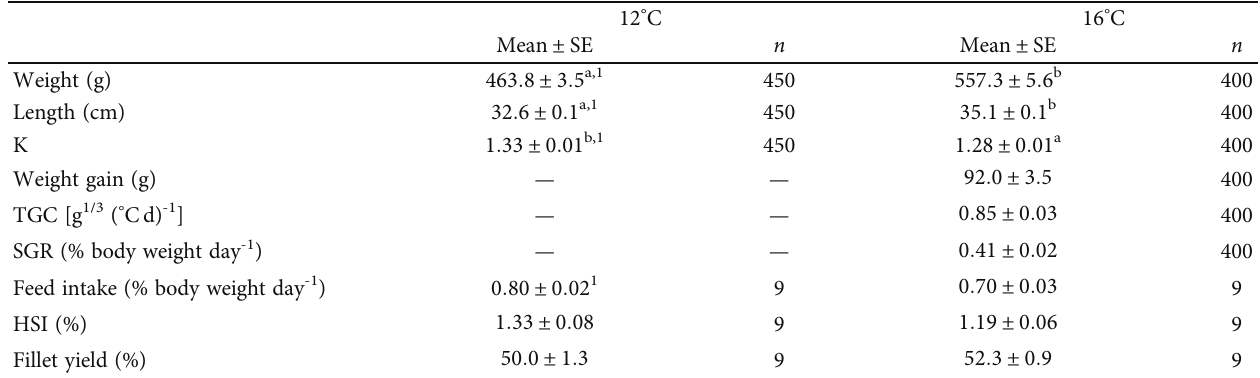
Table 4: Morphological and production metrics for Atlantic salmon fi rst reared at 12 ° C and fed the control diet for a period of 16 days, and then after exposed to an incremental temperature increase up to 16 ° C (at 0.2 ° C day -1 ).